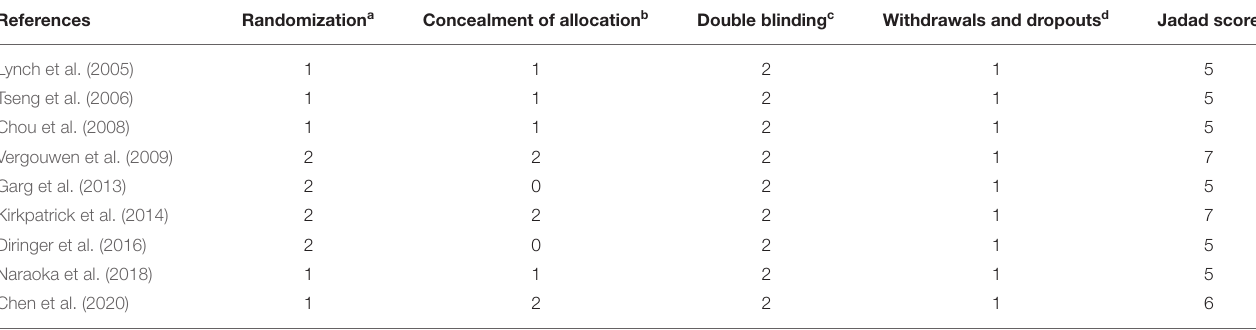
TABLE 2 | Quality assessment of the included studies.